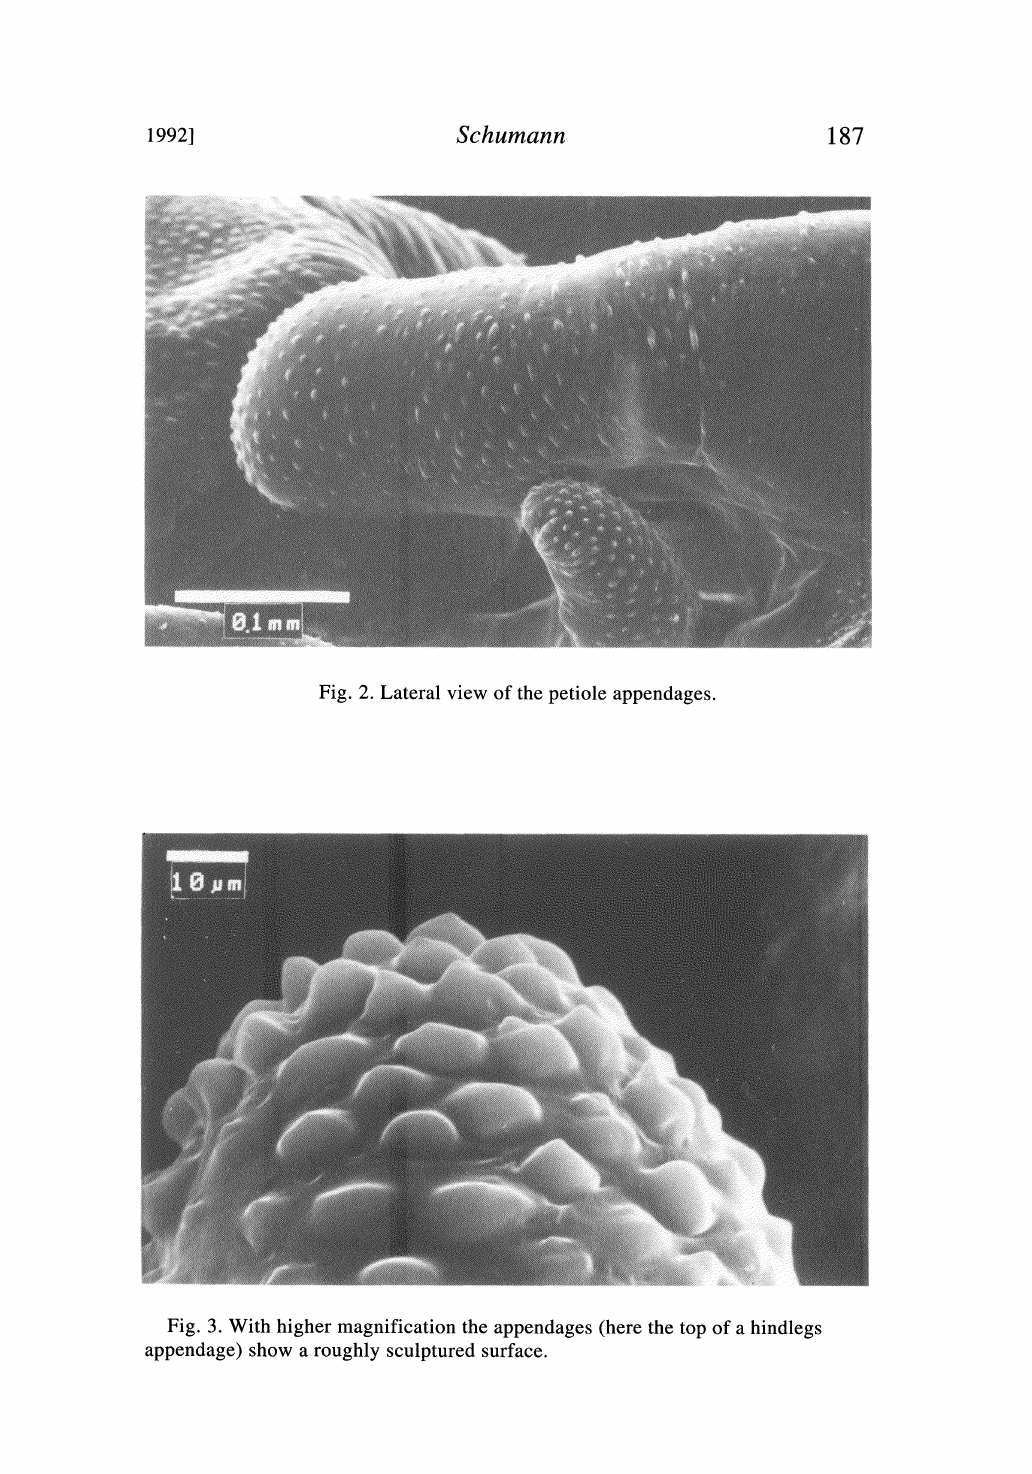
Fig. 3. With higher magnification the appendages (here the top of a hindlegs appendage) show a roughly sculptured